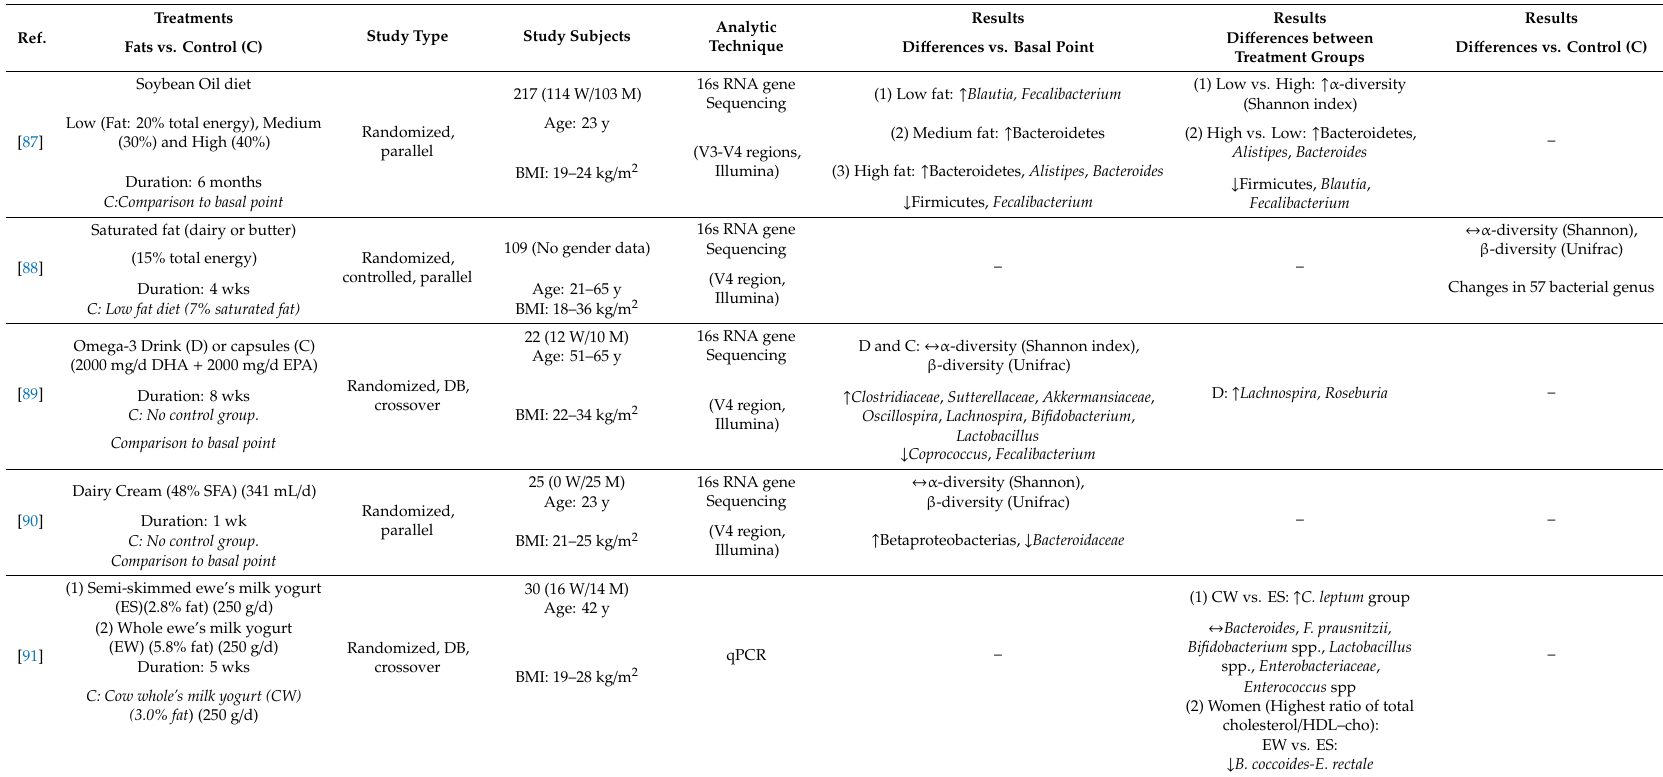
Table 5. Evidence from human studies relative to fats e ff ects on the gut microbiota composition of healthy adults.